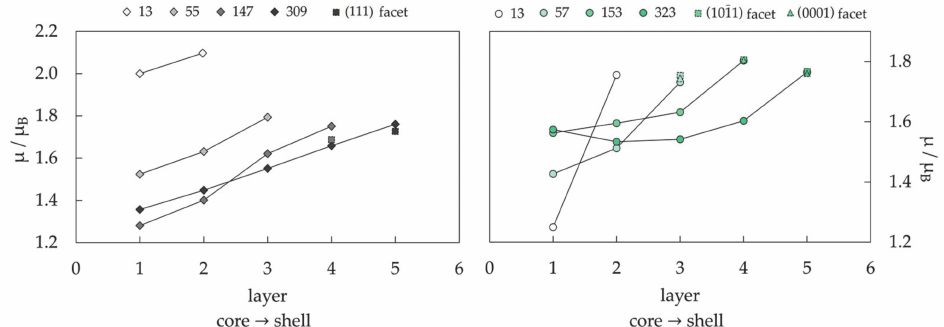
Figure 13. Magnetic moment per Co atom, µ , as a function of the Co NP layers for increasing nanoparticle size— left : icosahedral NPs, right : hcp NPs. Layers are numbered going from the core to the shell of the